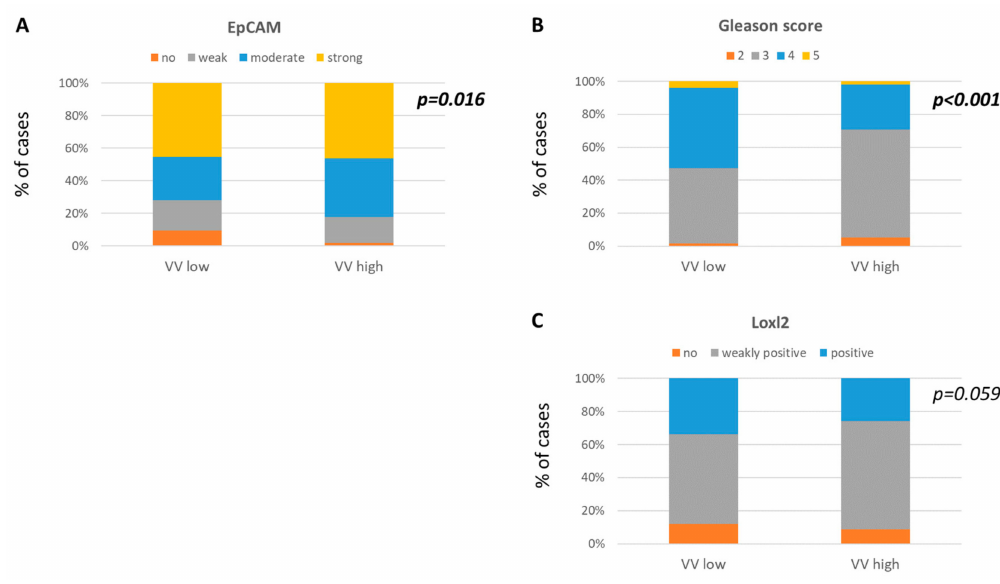
Figure 3. Molecular characteristics of PCa in comparison to VV status. VV low correlations to less frequent ( A ) EpCAM expression, ( B ) higher Gleason score, and borderline correlation to more frequent ( C ) Loxl-2